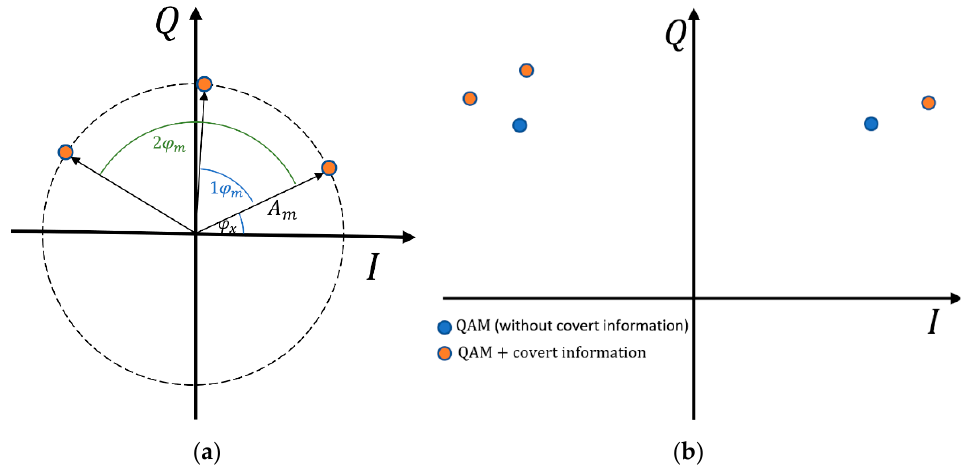
Figure 2. Example of constellation with drift phase: ( a ) vector y k for K = 3; ( b ) quadrature amplitude modulation (QAM) cover (transmitted overt sequence of symbols: 1 + j, 1 − j, 1 − j) and resultant constellation with drift phase applied for preset vector y k .